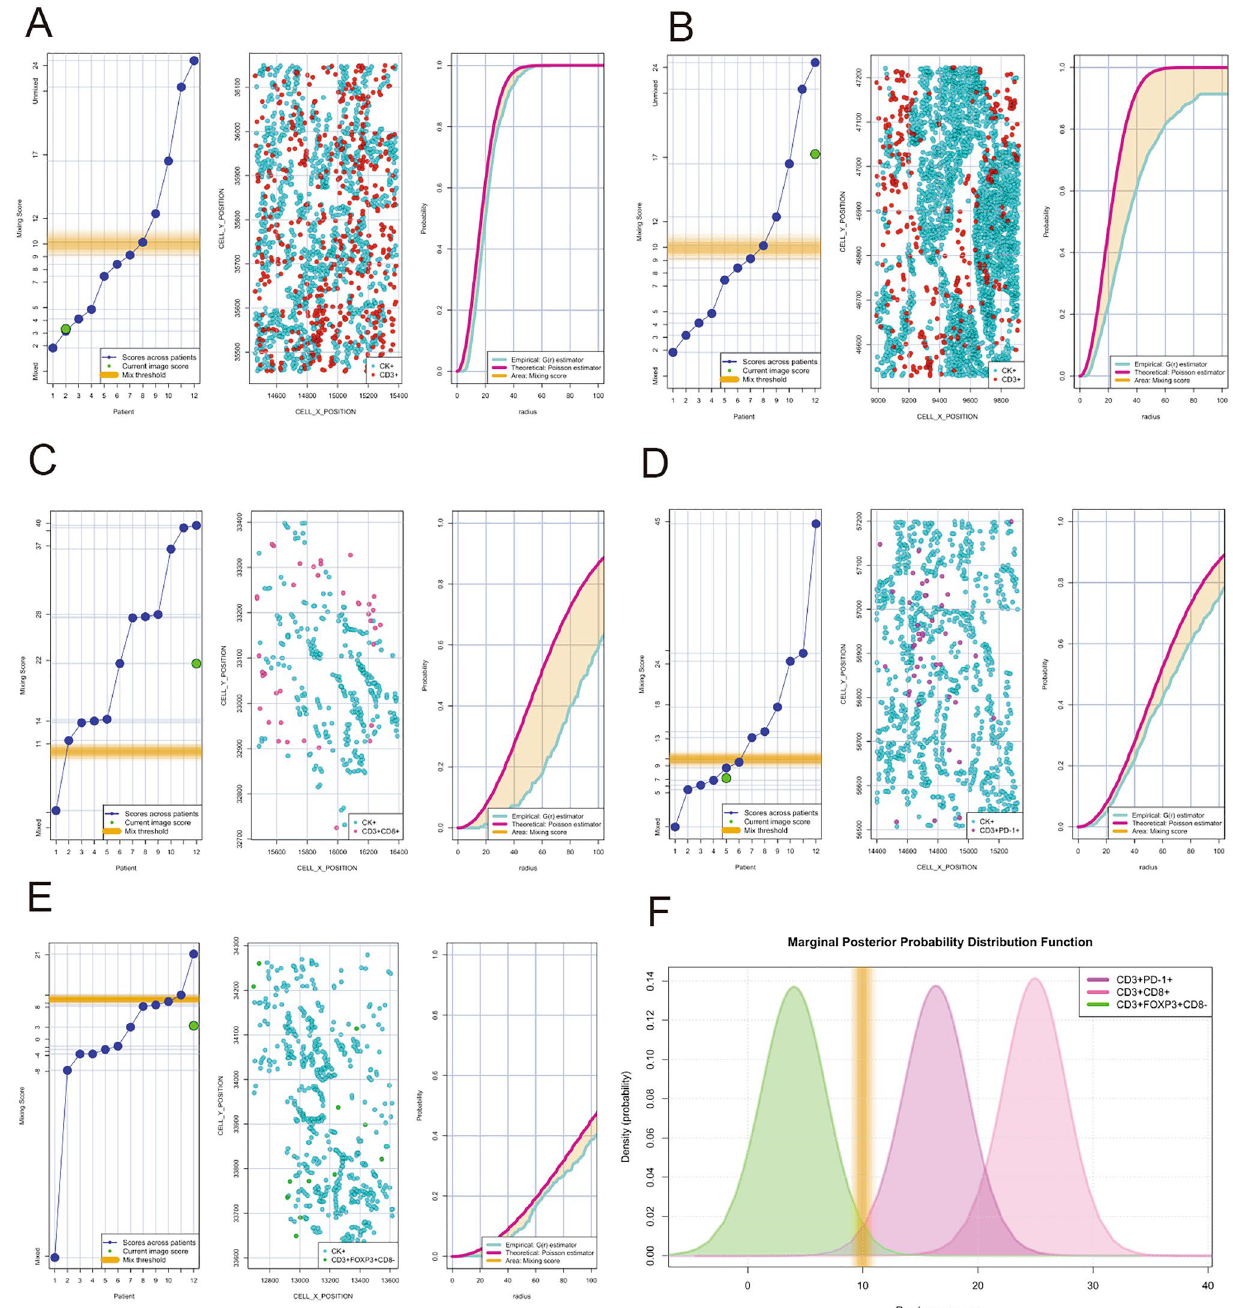
Figure 5. Individual nearest neighbor distance G function and theoretical Poisson curves graphics for the identification of different cellular patterns of distance distribution from malignant cells (panCK +) to T-cells CD3 + phenotypes. ( A to E ) showing the scoring scale that the image represent across the cases and the threshold to be considered mixed or unmixed pattern ( left side ) , graphic distribution representation of the T-cell phenotypes and panCK cells ( middle side ) and the nearest neighbor distance G function and theoretical Poisson curves area ( right side ). ( A ) Mixed pattern distribution between T-cells CD3 + and panCK + cells, ( B ) unmixed pattern distribution between T-cells CD3 + and panCK + cells, ( C ) unmixed pattern distribution between cytotoxic T-cells (CD3 + CD8 +) and panCK + cells, ( D ) mixed pattern distribution between antigen experienced T-cells (CD3 + PD + 1) and panCK + cells, ( E ) mixed pattern distribution between regulatory T-cells (CD3 + Foxp3 + CD8-) and panCK + cells, and ( F ) graphical model showing the spatial distribution interaction between cytotoxic T-cells, antigen experienced T-cells and regulatory T-cells related to malignant cells showing the different curves of distribution according the T-cell phenotypes analysed. The images were generated using R studio software version